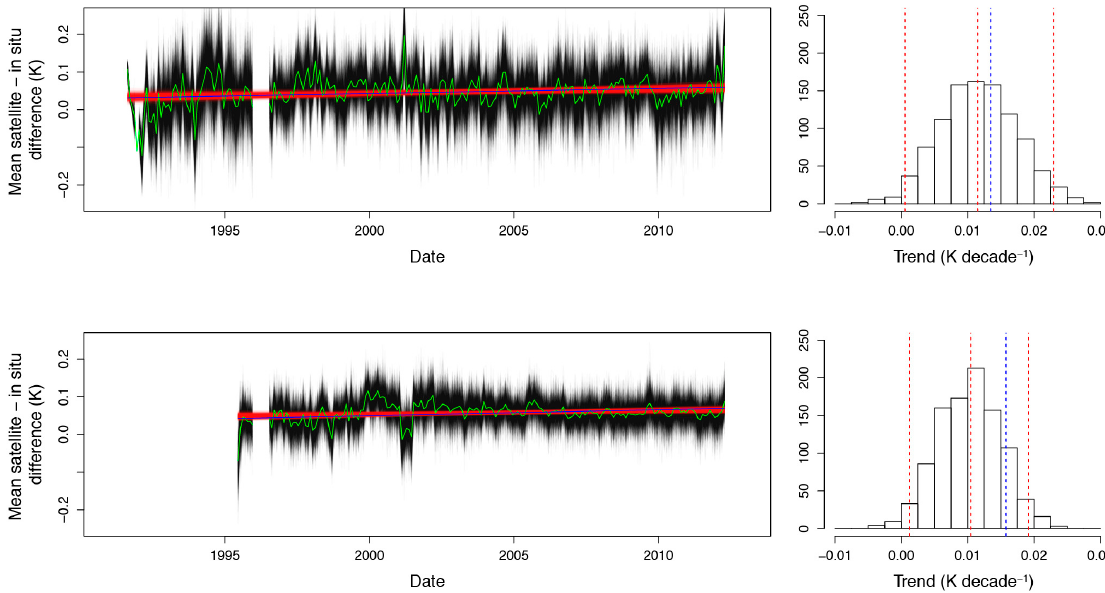
Figure 11. Panels ( a , c ): time series of the individual ensemble mean differences as a function of time (black lines) using observations from the ( a ) GTMBA and ( c ) drifting buoys, fitted AR1 trend models (red lines), mean differences averaged across all available match-ups (green lines) and AR1 model fitted to the mean of all available match-ups. Panels ( b , d ): histograms of the estimated trends across the ensembles for the ( b ) GTMBA and ( d ) drifting buoy data. The red dashed lines indicate the 2.5%, 50% and 97.5% quantiles. The blue dashed line indicates the trend fitted using all available match-ups. Table 8. Trend and trend uncertainty estimates for the AR1 model applied to the GTMBA and drifting buoy ensembles.